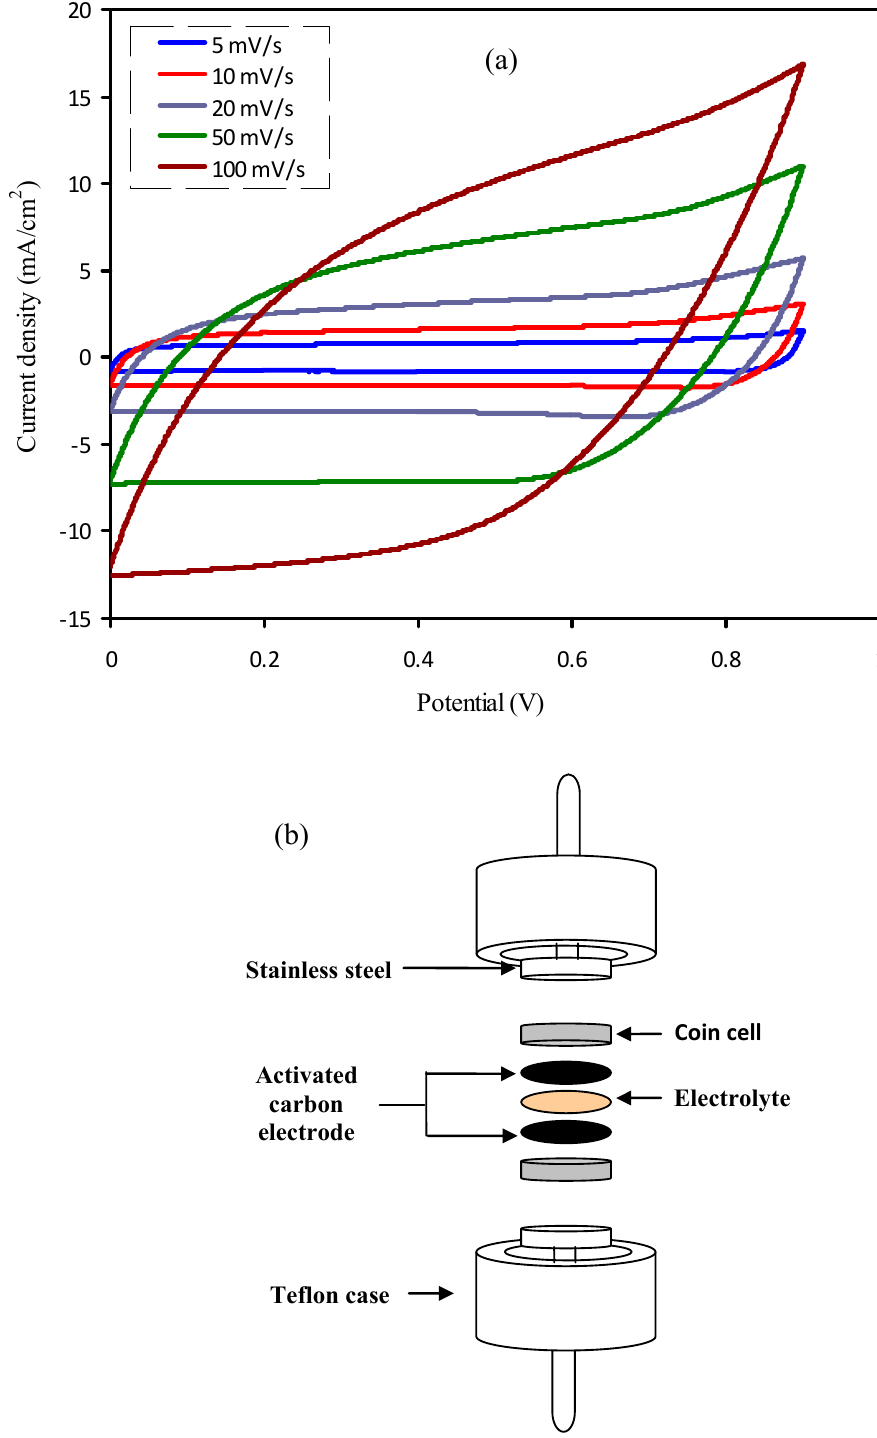
Figure 7. ( a ) Cyclic voltammetry (CV) curve of the developed electrical double-layer capacitor ( EDLC) for the PNCG-4 film of PCE and ( b ) schematic diagram of EDLC setup for CV measurement.